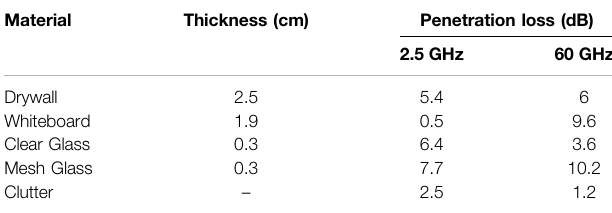
TABLE 1 | Comparison between penetration loss measurements obtained at 2.5 and 60 GHz (Anderson and Rappaport, 2004).